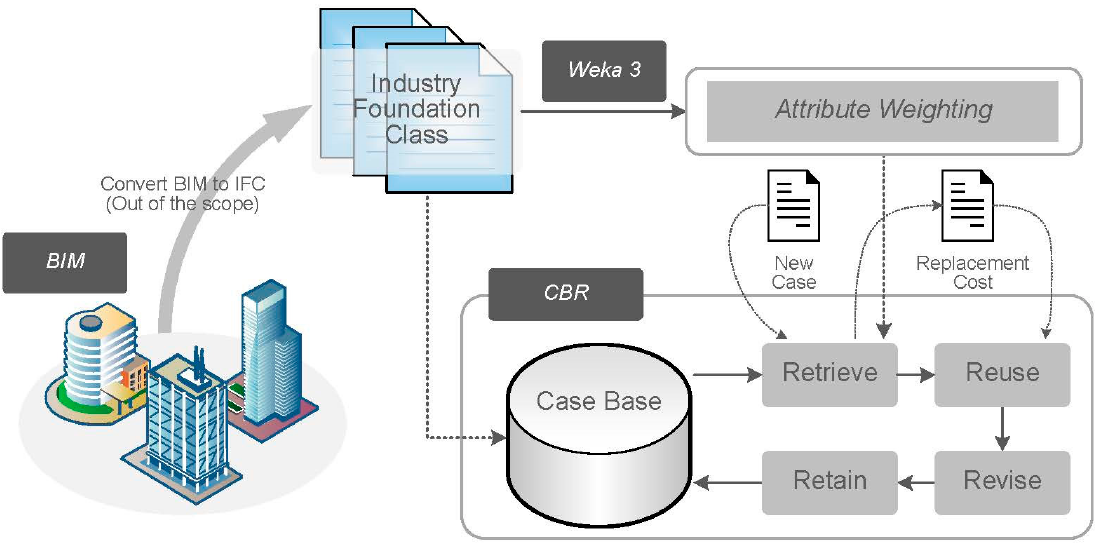
Figure 1. Research framework. Industry Foundation Class (IFC); Building information modeling (BIM)